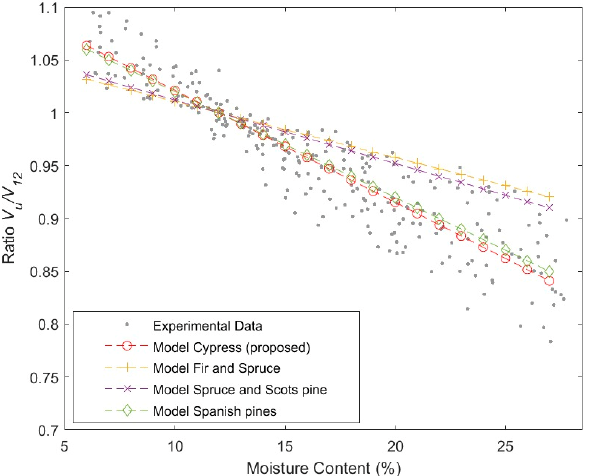
Figure 5. Comparison of adjustment equations to obtain longitudinal references velocity at 12% MC ( V 12 ) for softwood with the experimental data cypress.